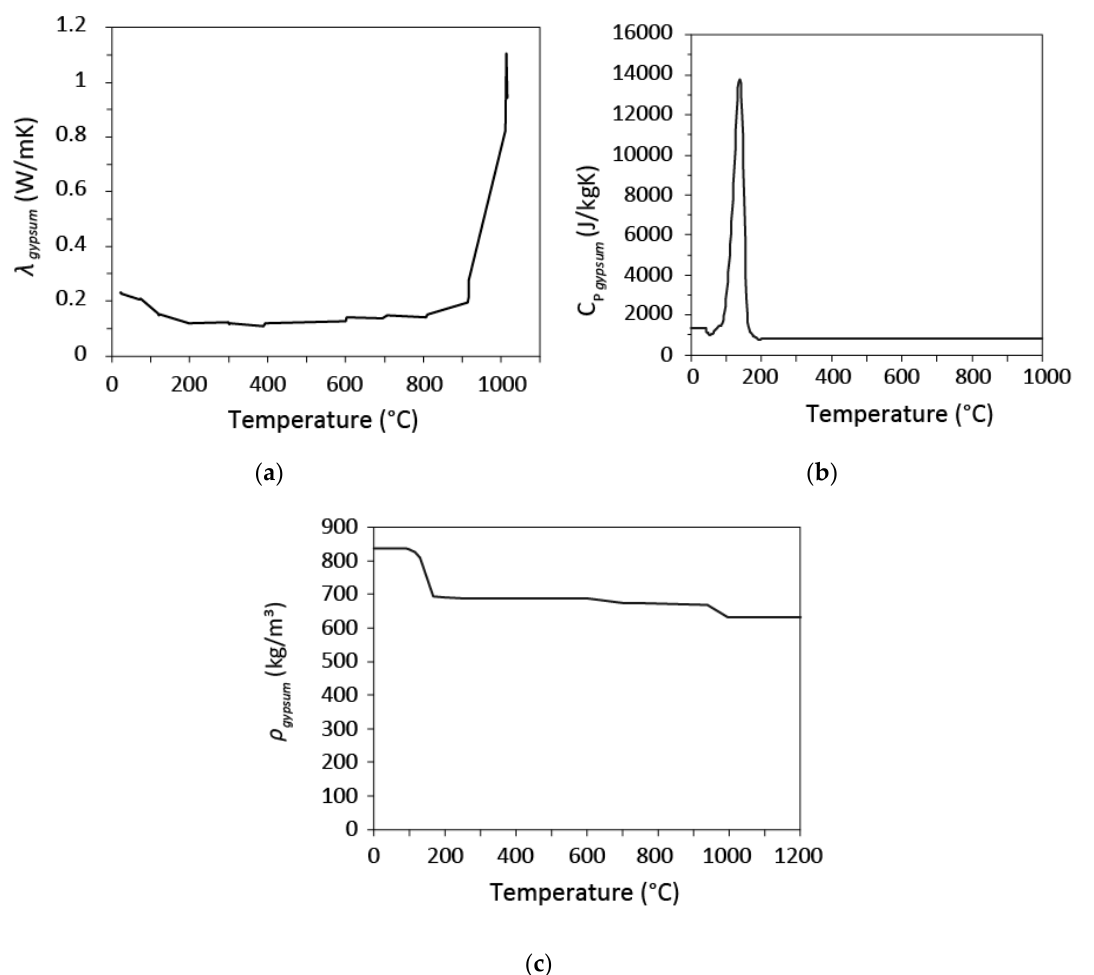
Figure 10. Temperature dependent properties of type X gypsum board: ( a ) Thermal conductivity; ( b ) specific heat; ( c ) density.